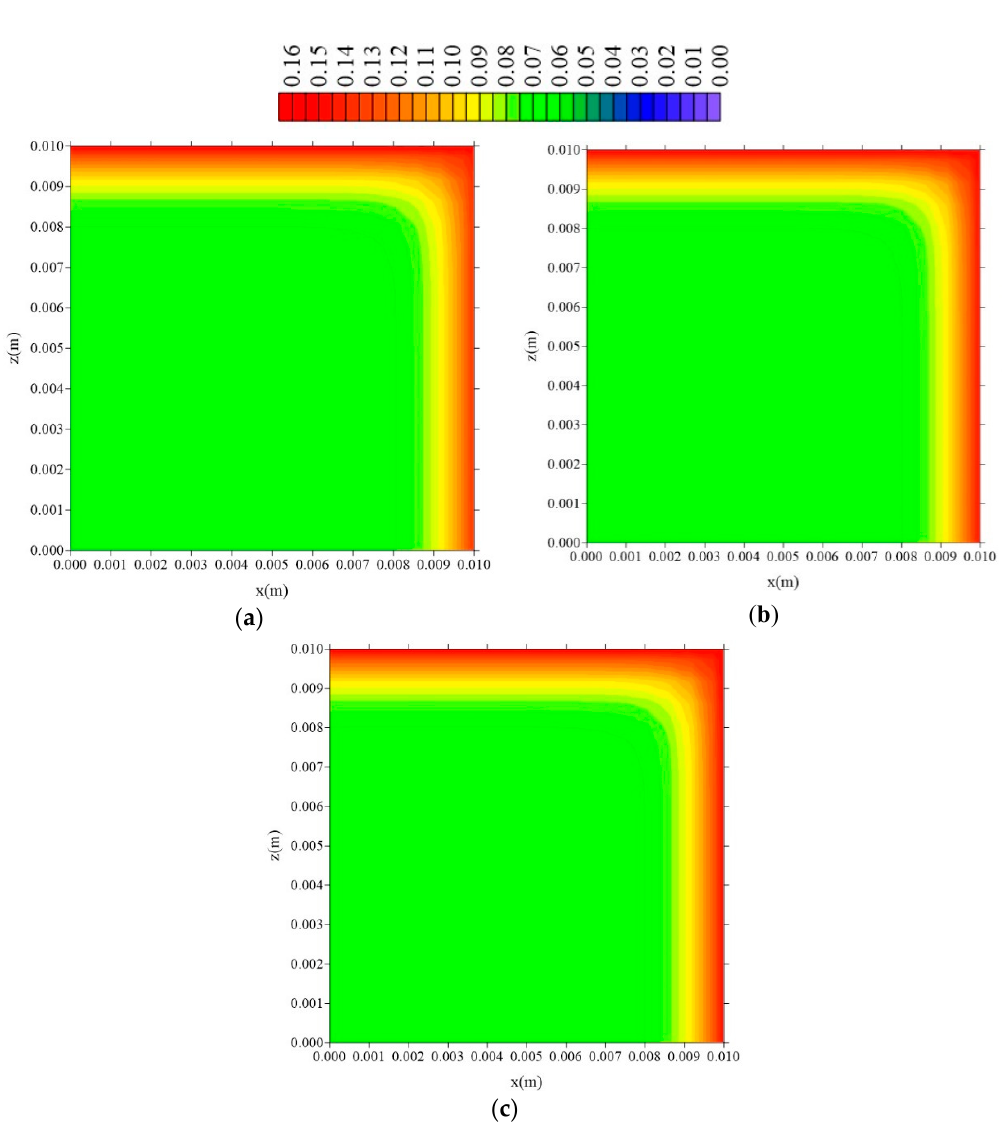
Figure 17. Distribution of free solute concentration (C in kg/kg) in plan y = R y /2 for different distances l x (t = 211 h, Cases 8, 9, and 10). In which ( a ) l x = 0.01 m; l y = 0.01 m and l z = 0.1 m; ( b ) l x = 0.1 m; l y = 0.01 m and l z = 0.1 m; ( c ) l x = 1 m; l y = 0.01 m and l z = 0.1 m.